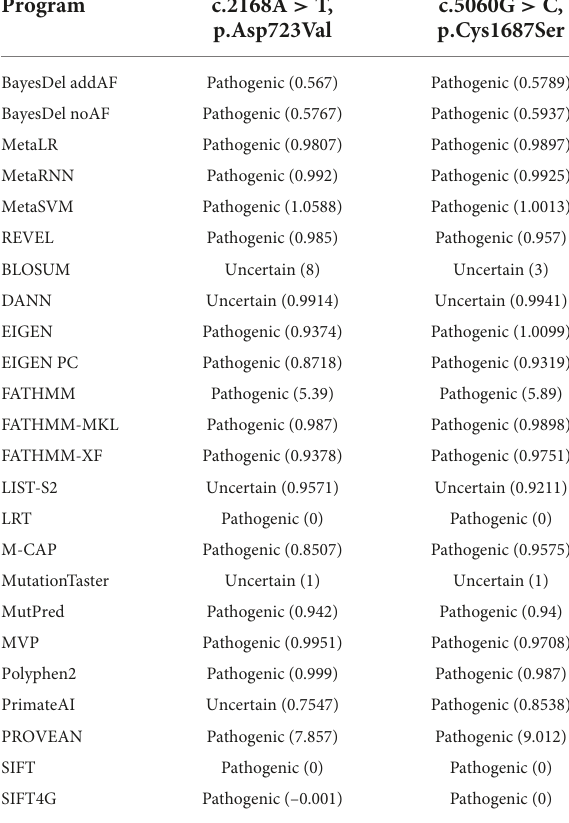
TABLE 1 Calibrated prediction of the possible functional impact of the FBN1 mutations by online